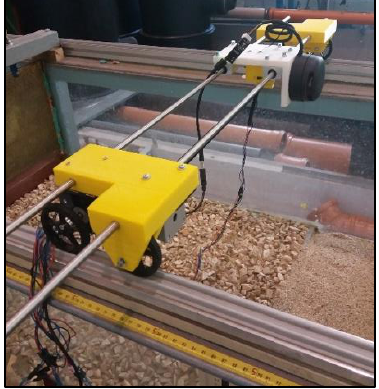
Figure 9. Laser scanner device on the steering wheels—prototype A2.